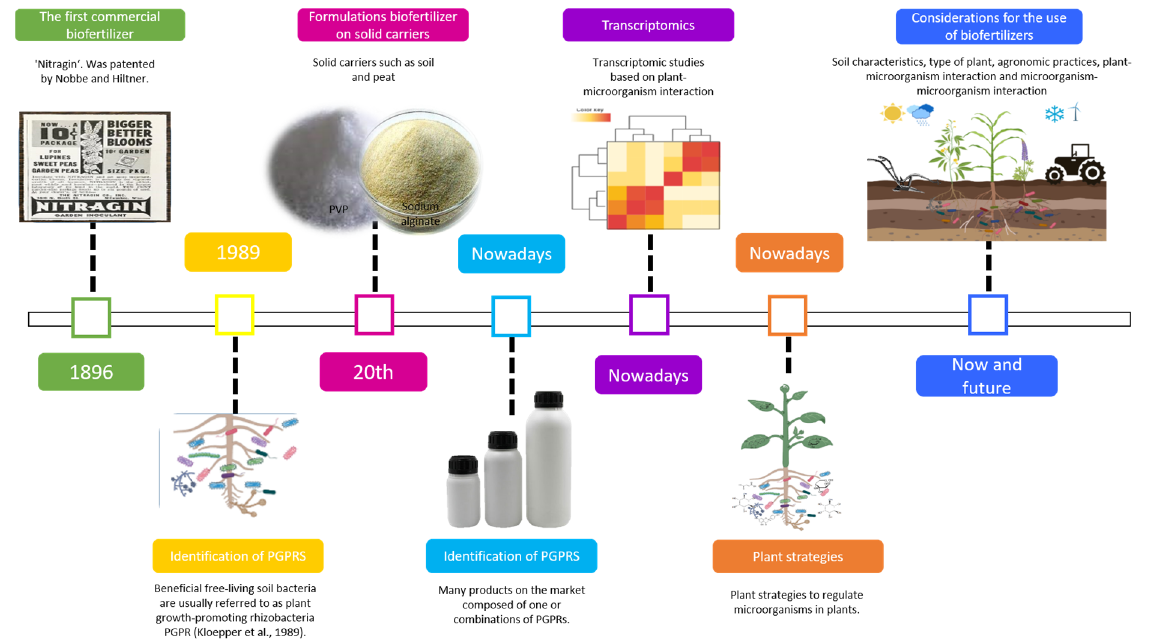
Figure 3. Past, present, and future of PGPRs as